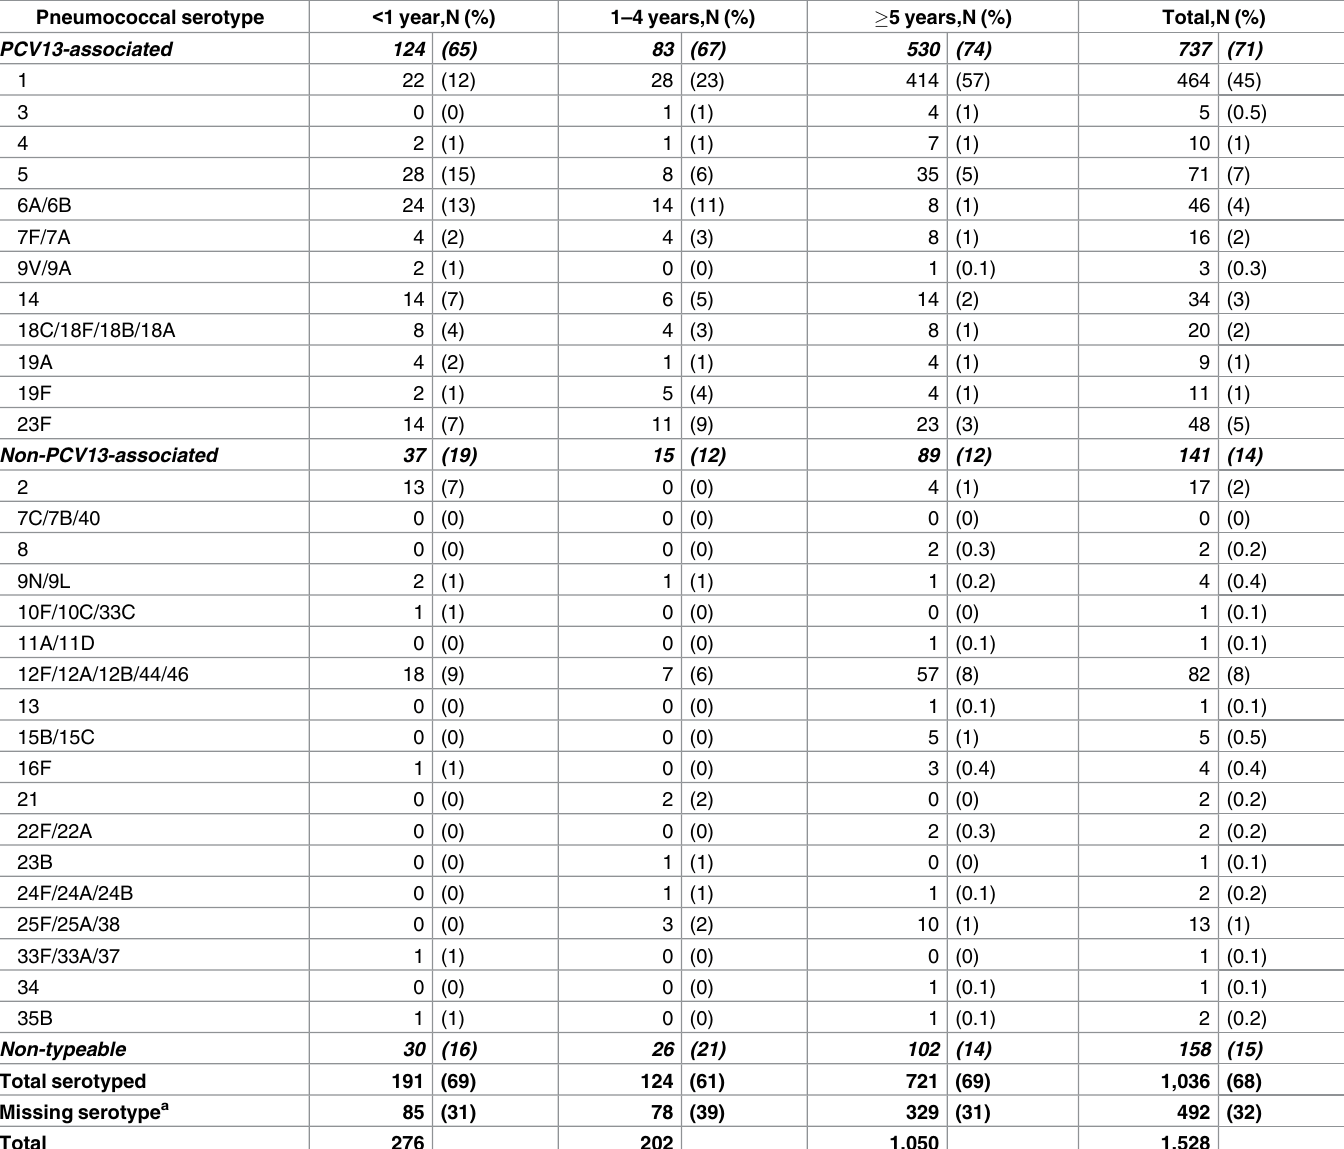
Table 5. Distribution of pneumococcal serotypesby age, Burkina Faso, 2011–2013. Pneumococcal